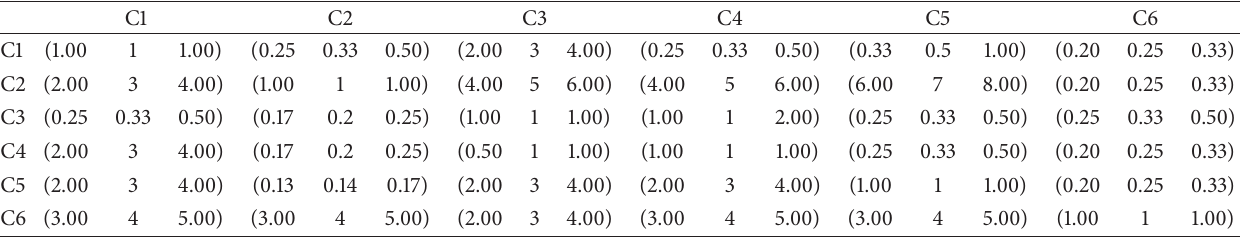
Table 4: The main criteria of pairwise comparison